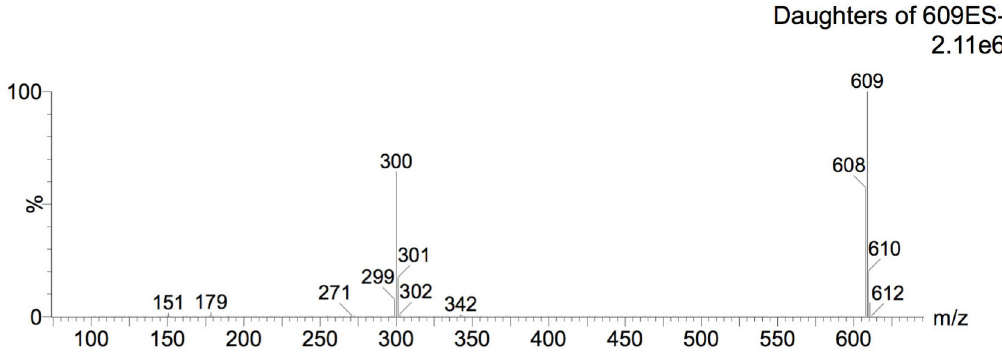
Fig 12. Mass spectrum on ESI negative mode under MRM monitoring for molecular ion m/z 609.